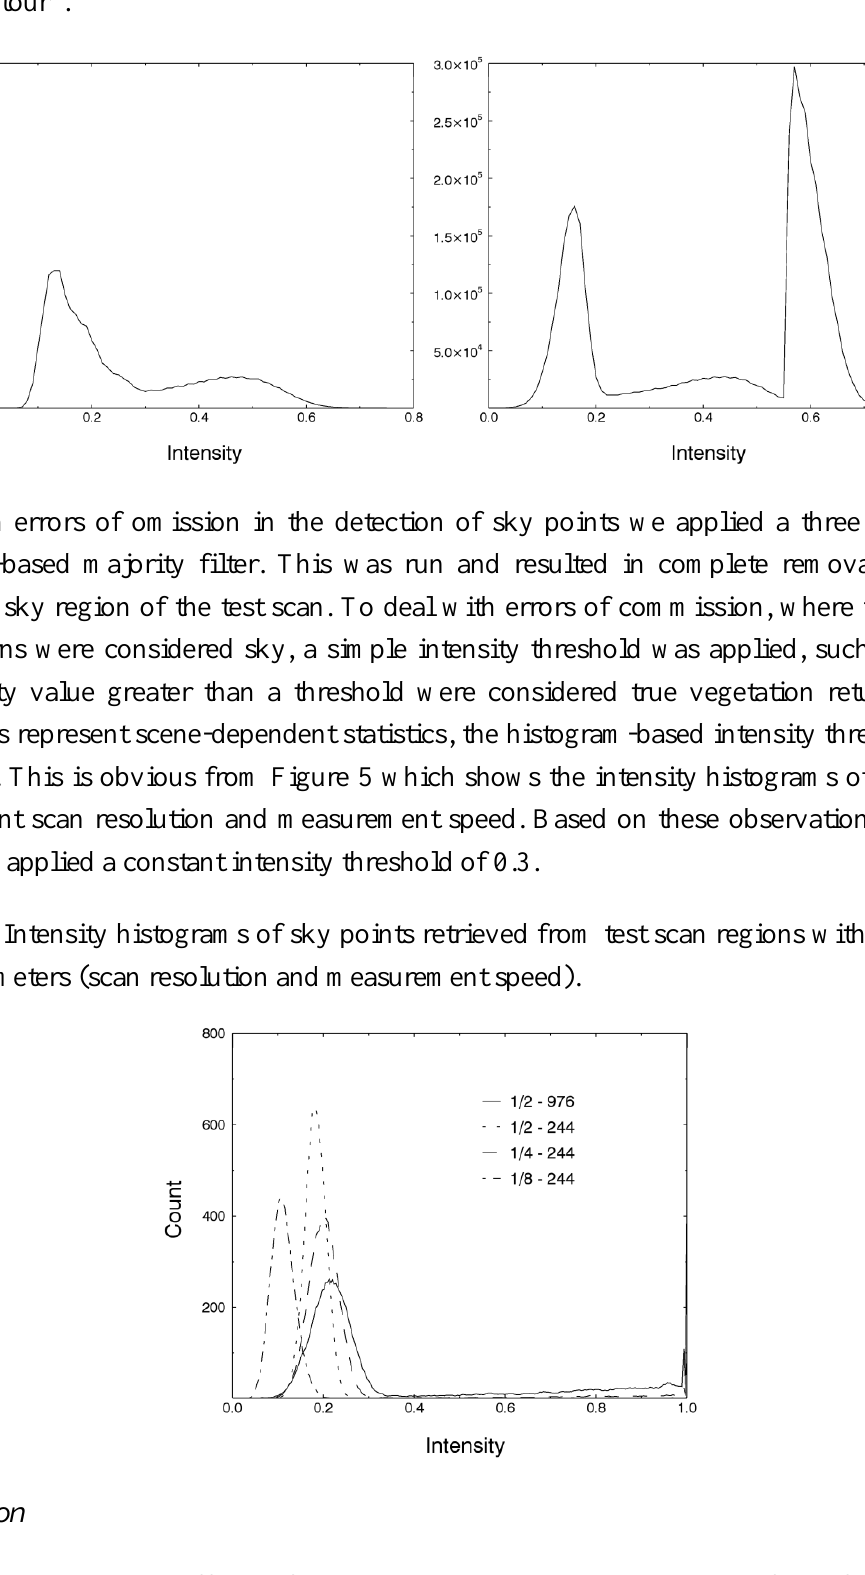
Figure 4. Intensity histograms of all filtered scan points retrieved from the second set of test scans. ( a ) Scan filtered only with ―clear sky‖. ( b ) Scan filtered with ―clear sky‖ and ―clear contour‖.